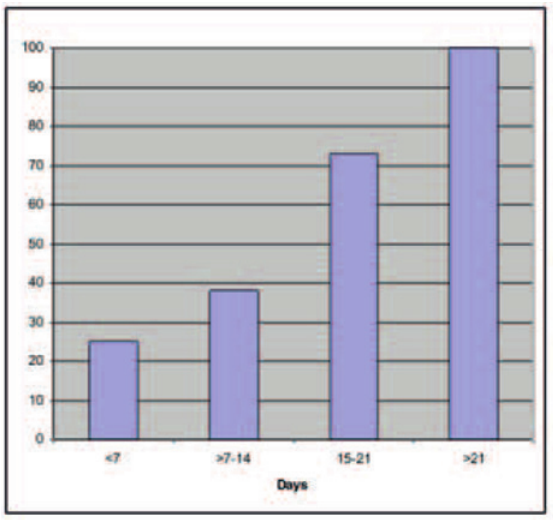
Figure 1. Incidence rate of pancreatic necrosis in severe AP is time